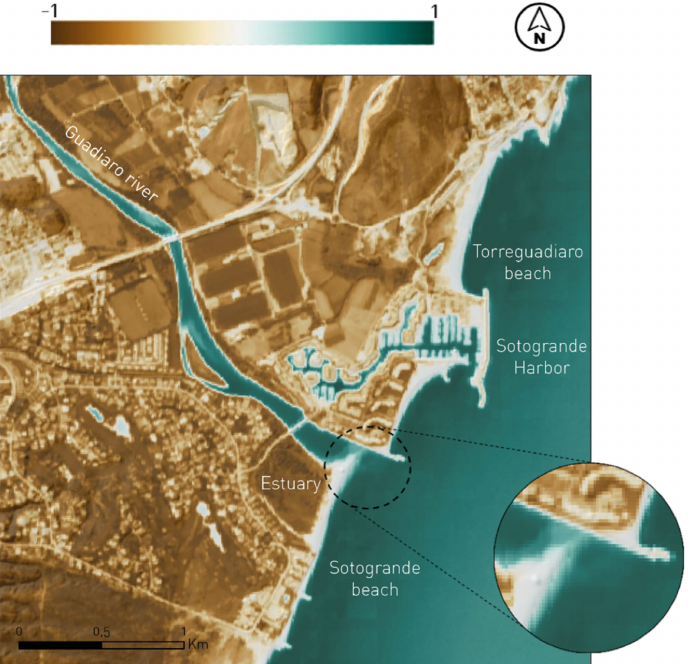
Figure 6. Total climatology (2017–2020) using Sentinel-2 L2A images and NDWI index for the Gua-diaro river mouth. Scale 1:15,000.